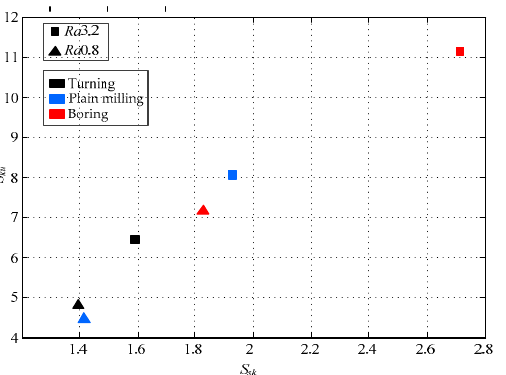
Figure 9. The skewness and kurtosis values for the turning, plain milling, and boring surfaces for selected roughness grade of the normal declination angle distribution.